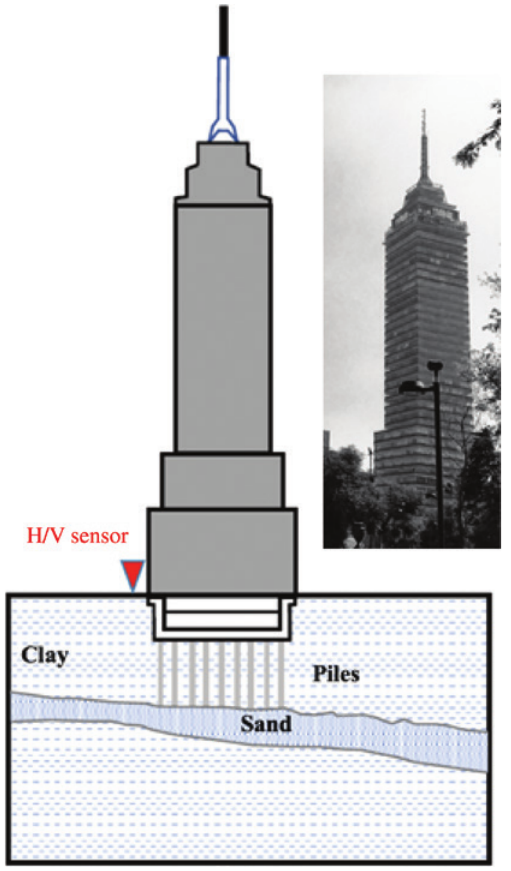
Figure 12: Schematic of Torre LatinoAmericana (182 m) and its deep pile-foundations.